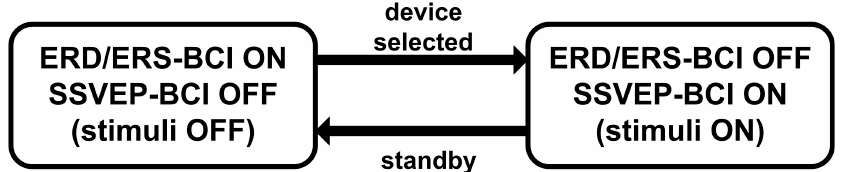
Figure 9. Hybrid ERD/ERS-SSVEP BCI with sequential processing. The ERD/ERS-BCI acts as a selector which activates the SSVEP system.